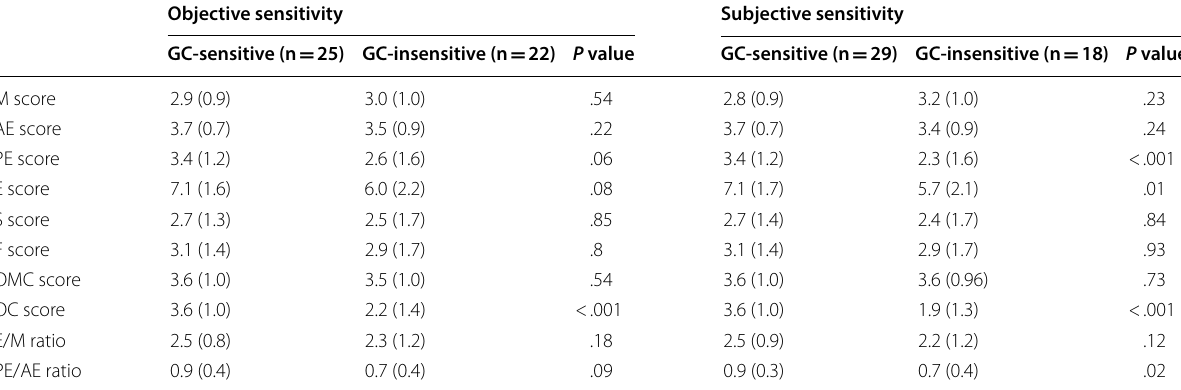
GC, glucocorticoid; M score, maxillary sinus score; AE score, anterior ethmoid sinus score; PE, posterior ethmoid sinus score; E score, total ethmoid sinus score; S score, sphenoid sinus score; F score, frontal sinus score; OMC score, ostiomeatal complex score; OC score, olfactory cleft score; E/M ratio, ratio of the E and M scores; PE/AE ratio, ratio of the PE and AE scores